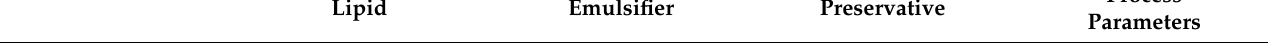
Table 2. Composition of emulsions and process parameters. HPH = High-pressure homogenization; PME = premix membrane emulsification. Lipid Emulsifier Preservative Kinetics of drug loading, influence of the lipid matrix and influence of drug load on emulsion